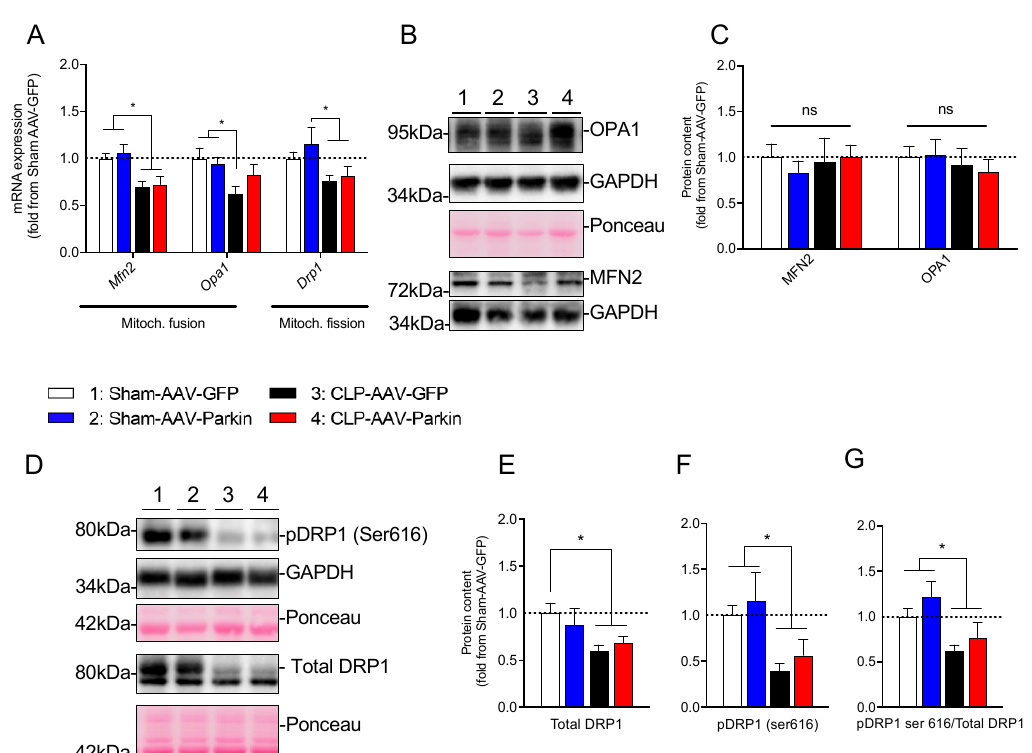
Figure 6. The impact of sepsis and Parkin overexpression on mitochondrial dynamics in skeletal muscle. ( A ) qPCR analysis of mitochondrial dynamic-related gene expression in the GAS muscles of Sham and CLP animals injected with either AAV-GFP or AAV-Parkin. ( B ) Representative immunoblots of OPA1, GADPH and MFN2. Ponceau stains or GAPDH immunoblots were used as loading controls. ( C ) Quantification of OPA1, GADPH and MFN2 content. ( D ) Representative immunoblots performed with primary antibodies against pDRP1(ser616) and total DRP1. Ponceau stains or GAPDH immunoblots were used as loading controls. ( E ) Quantification of DRP1 content. ( F ) Quantification of the contents of pDRP1(ser 616) content. ( G ) Quantification of the pDRP1(ser 616) to total DRP1 ratio. 1 = Sham-AAV-GFP; 2 = Sham-AAV-Parkin; 3 = CLP-AAV-GFP; 4 = CLP-AAV-Parkin. Data are presented as mean ± SEM. ( n = 6–9 / group; * = statistically significant; ns = not statistically significant).